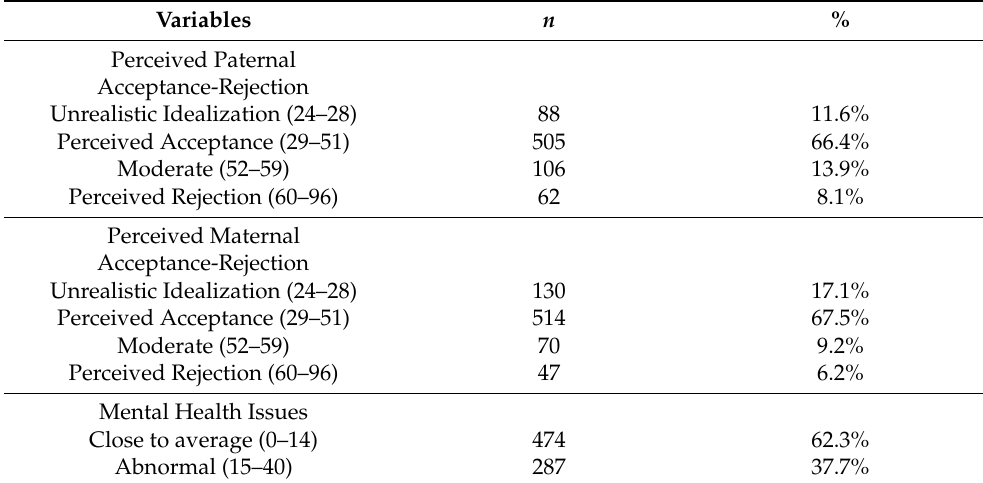
Table 1. Descriptive Statistics of the Study Variables (N =